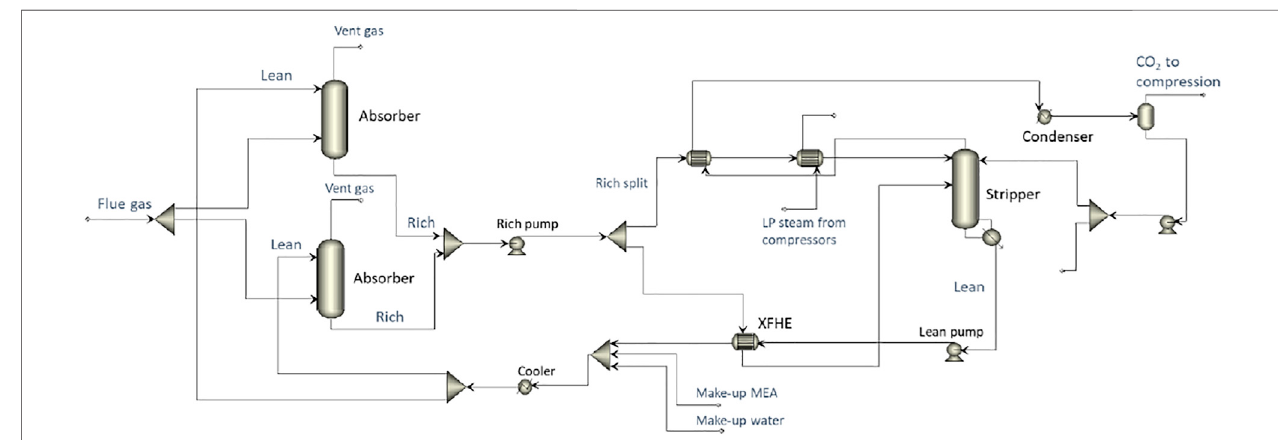
FIGURE 1 | Process fl ow diagram as implemented in the Aspen Plus